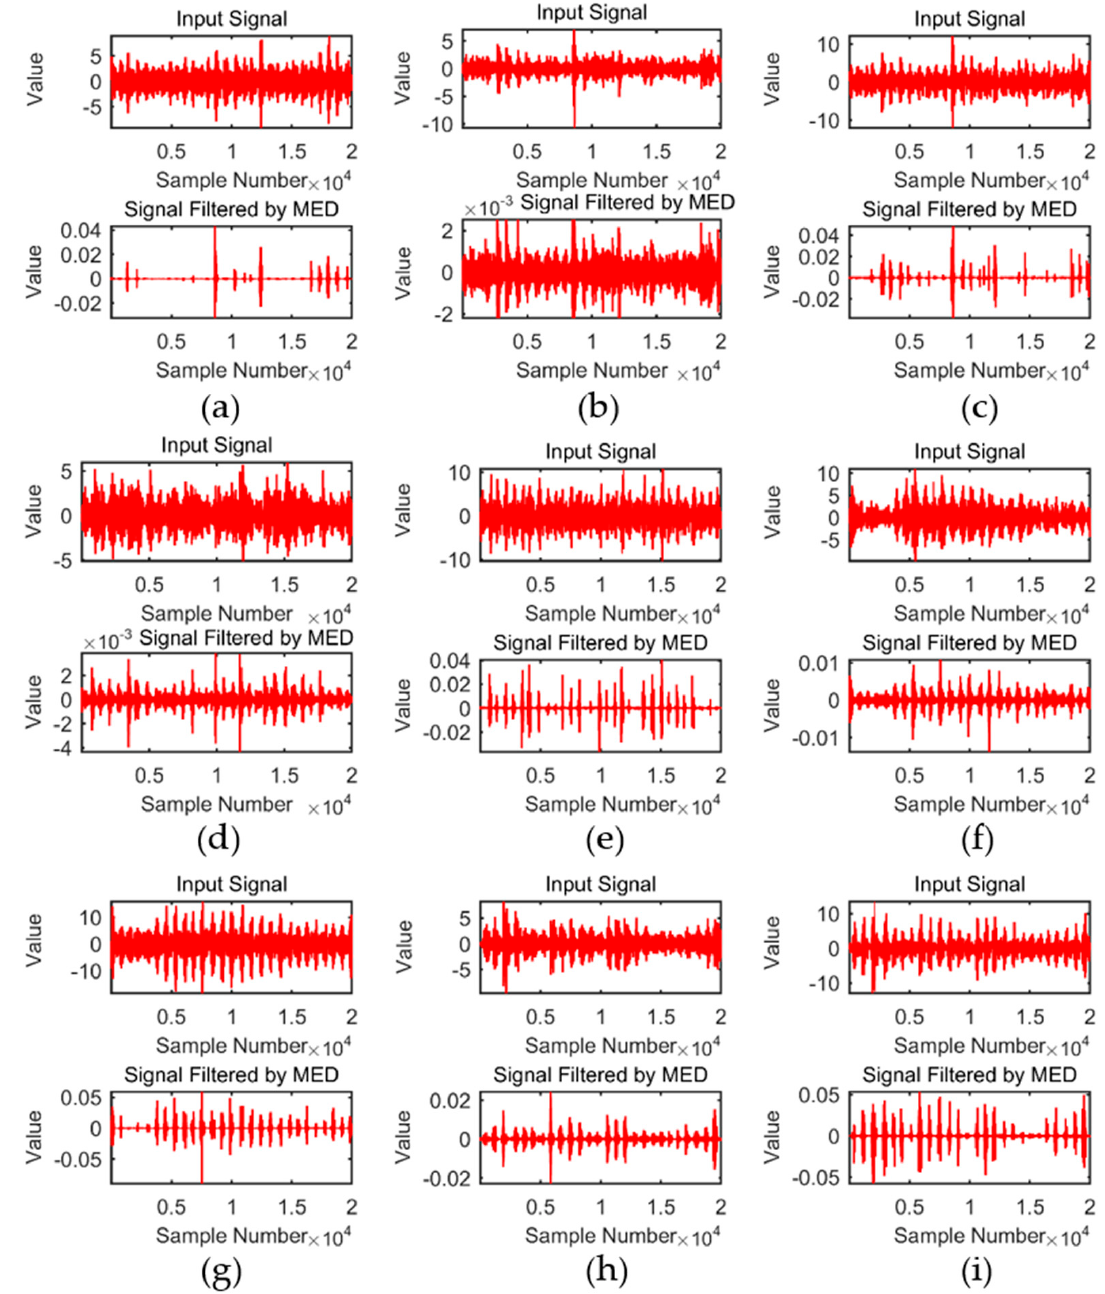
Figure 7. Material vibration signal waveform with changing ultrasonic amplitude. ( a ) Ultrasonic amplitude of 30%; ( b ) Ultrasonic amplitude of 35%; ( c ) Ultrasonic amplitude of 40%; ( d ) Ultrasonic amplitude of 45%; ( e ) Ultrasonic amplitude of 50%; ( f ) Ultrasonic amplitude of 55%; ( g ) Ultrasonic amplitude of 60%; ( h ) Ultrasonic amplitude of 65%; ( i ) Ultrasonic amplitude of 70%.